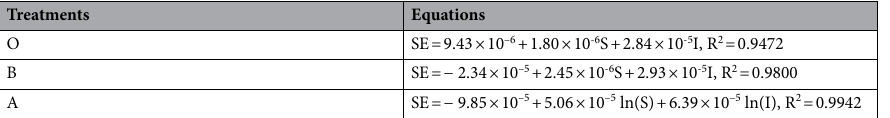
Table 5. The relationship between the sheet erosion rate and the slope or rain intensity . SE is sheet erosion rate, S is Slope ( o ),I is Rainfall intensity(mm/min). The significance level of the equation is 0.05. O is bare slope, B is Prunella vulgaris combined with earthworm planting slope,A is Single planting prunella vulgaris slope.